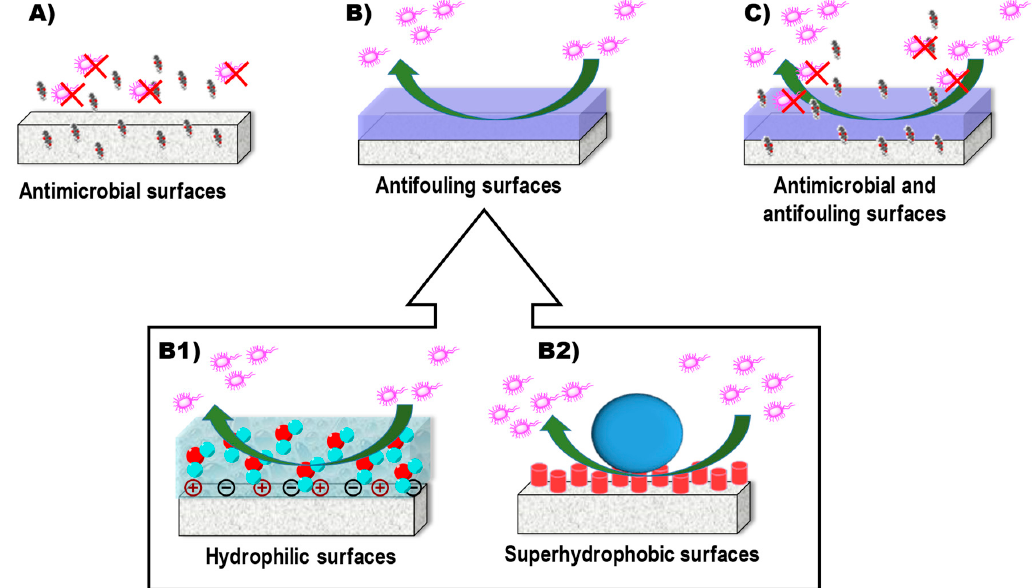
Figure 7. Current strategies for developing biofilm-resistant biomaterials. ( A ) Antimicrobial-loaded/functionalized materials; ( B ) antifouling materials due to ( B1 ) hydrophilic or ( B2 ) superhydrophobic surfaces; ( C ) combining antifouling and antimicrobial effects in the same material.